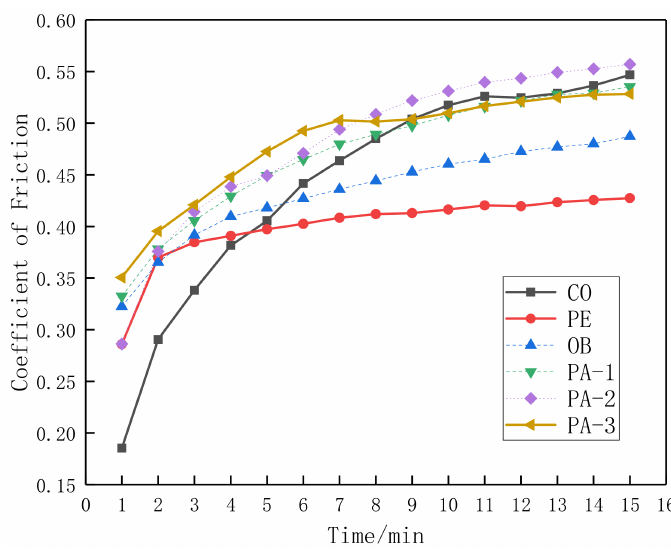
Figure 4. Comparison of friction